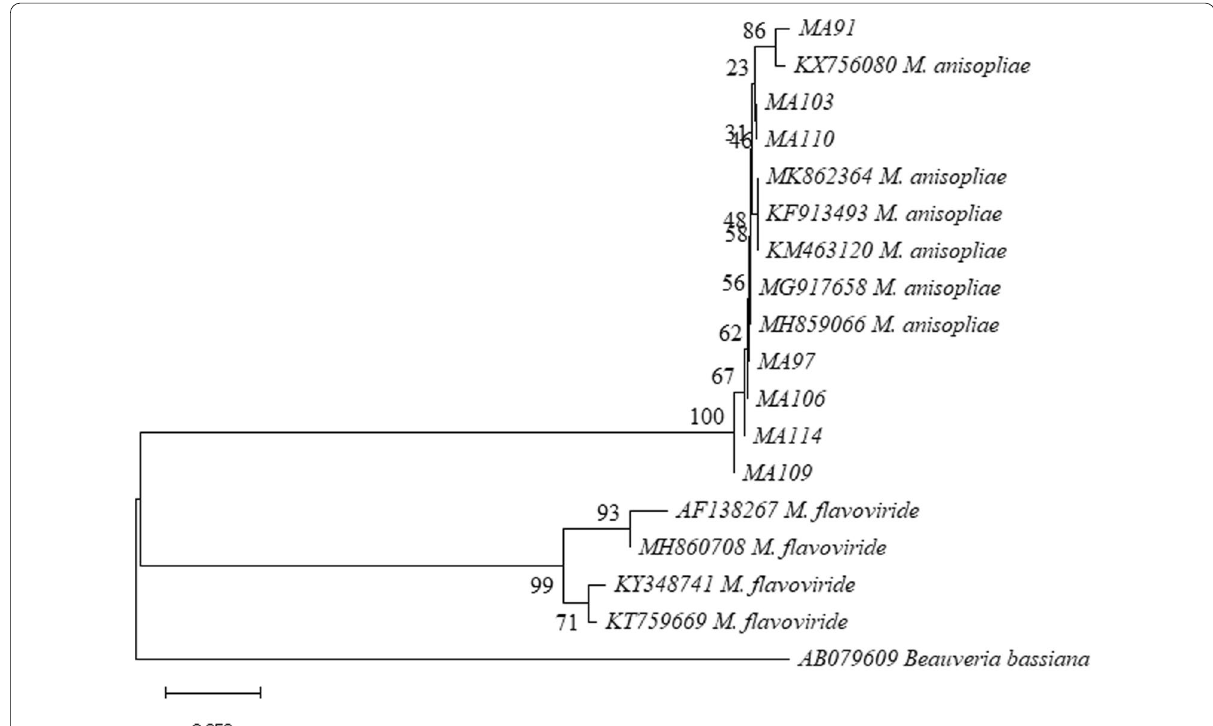
Fig. 1 Phylogenetic relationship of seven isolates of Metarhizium spp. The tree was constructed from the analysis of ITS-5.8s rDNA gene sequencing by the neighbor-joining method